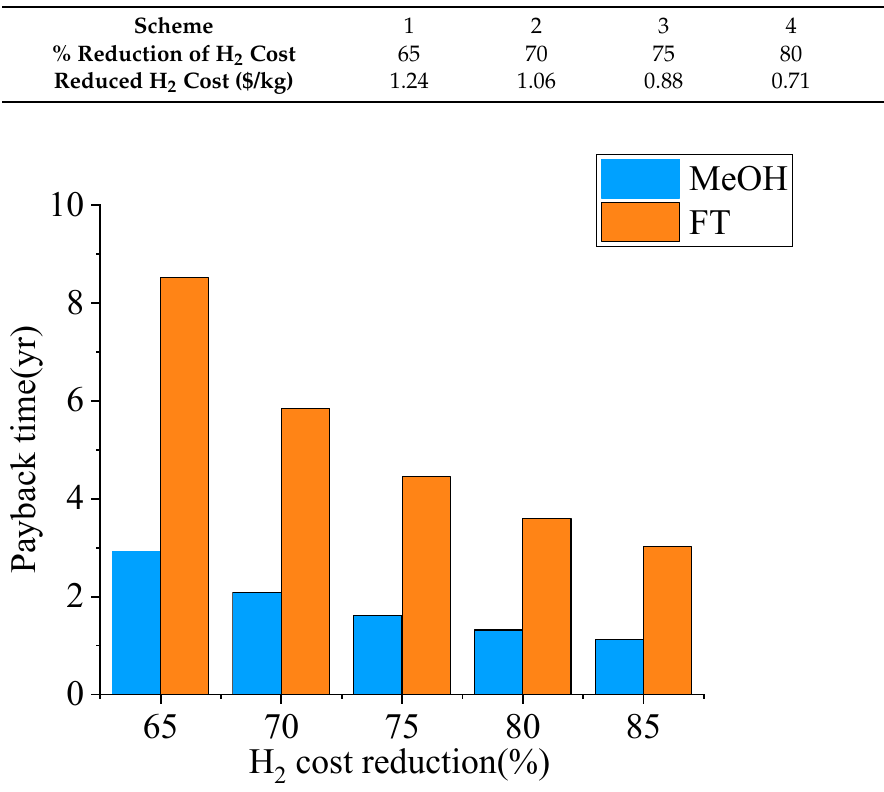
Table 3. Reduced hydrogen cost scenarios considered for the defined payback time case study.